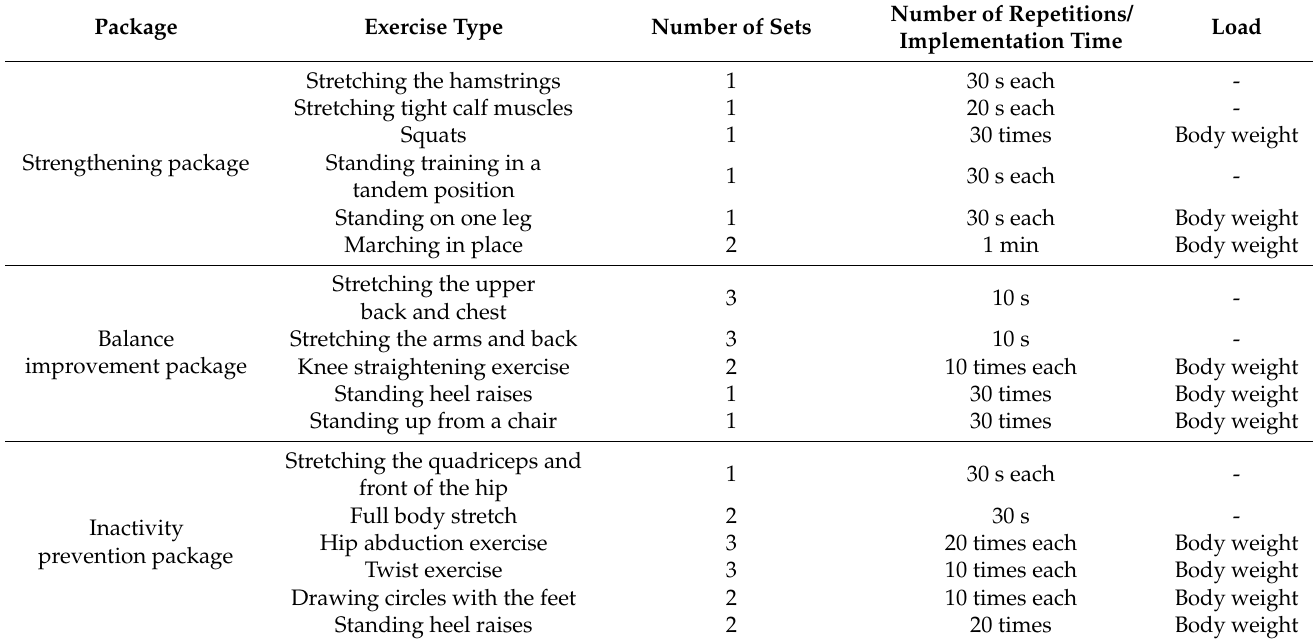
Table 2. Description of exercise content for each package of the